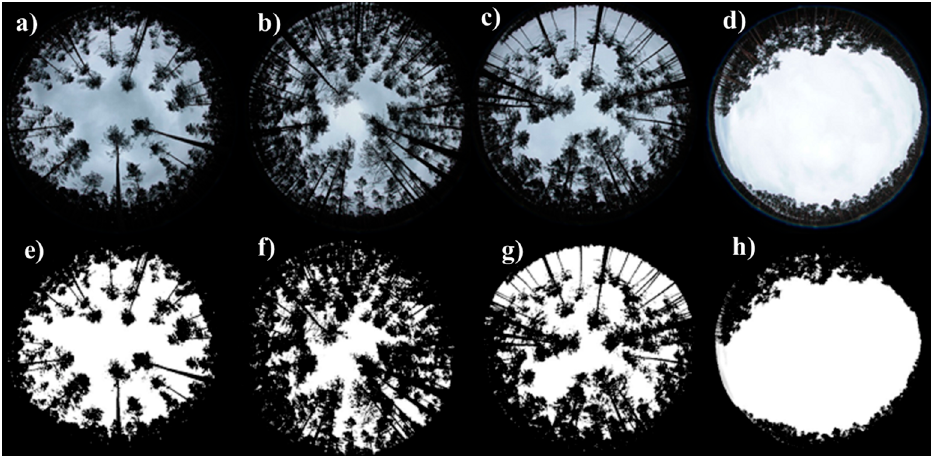
Figure 5. Fisheye images before ( a – d ) and after processing ( e – h ) in four different variants of ( a , e ) 30%, ( b , f ) 70%, ( c , g ) 50% and ( d , h ) 0%